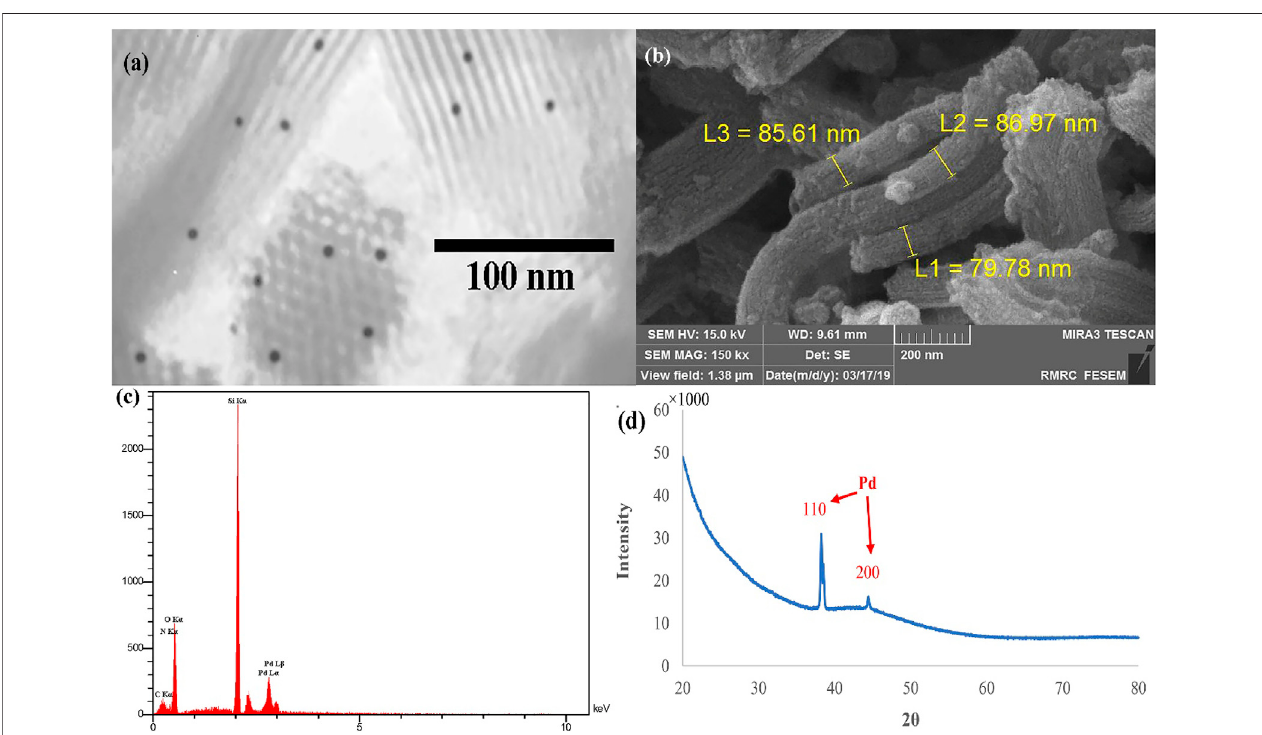
FIGURE 1 | (A) TEM; (B) SEM; (C) EDS; and (D) XRD results of the Pd@Py 2 PZ@MSN catalyst.